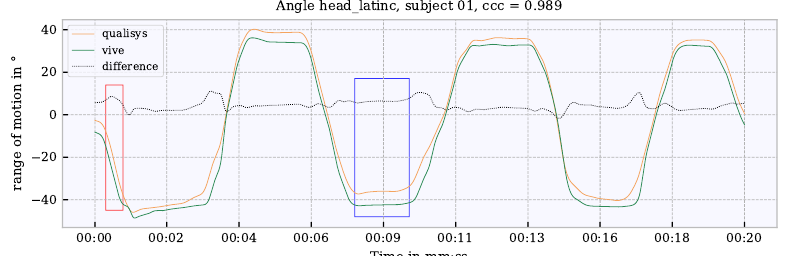
Figure 20. Differences caused by time shifts (red box). Differences which are relevant for the accuracy (blue